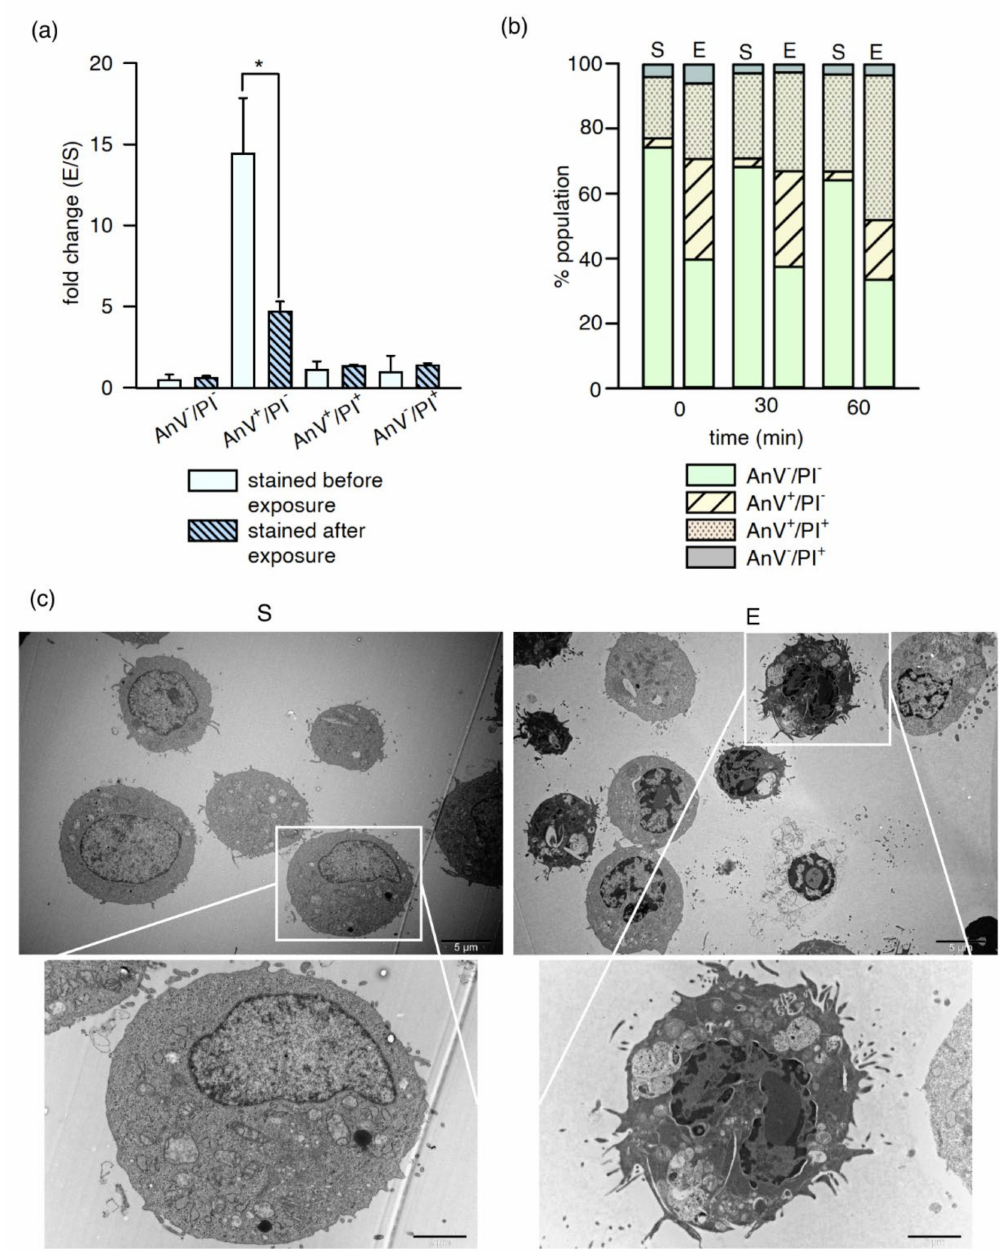
Figure 4. The presence of phosphatidylserine and other apoptosis-related changes in TM3 cells. S: sham-exposed cells. E: nsPEF-exposed cells. ( a ) The presence of phosphatidylserine on the membrane’s outer leaflet of cells stained with AnnexinV-Alexa Fluor 488 (AnV) and propidium iodide (PI) before the treatment with nsPEF, and immediately after treatment. Four populations of TM3 cells were distinguished by flow cytometry, and 10,000 events were recorded for each sample. The results are expressed as fold changes relative to sham-exposed samples. The bars represent median value and the 75th percentile of five (cells stained before exposure), or four (cells stained after exposure), independent experiments, with three biological repetitions per condition; the difference was significant (Student’s t -test (* p < 0.05)) for AnV + /PI - cells. ( b ) The phosphatidylserine’s externalization at the surface of cells stained before the nsPEF treatment, as described above; the percentage of cell populations in the samples S and E during 60 min post-exposure. The mean value of five (at 0 min), three (at 30 min), or two (at 60 min) independent experiments, with three biological repetitions per condition. ( c ) TEM images of sham- and nsPEF-exposed TM3 cells. Healthy cells with intact plasma and nuclear membranes predominate in sham-exposed control samples (left column). Numerous cells with morphological signs of apoptosis, such as nuclear membrane damage, chromatin condensation, and irregular cell outline, can be observed after nsPEF treatment (right column). The black bar represents 5 and 2 µ m,